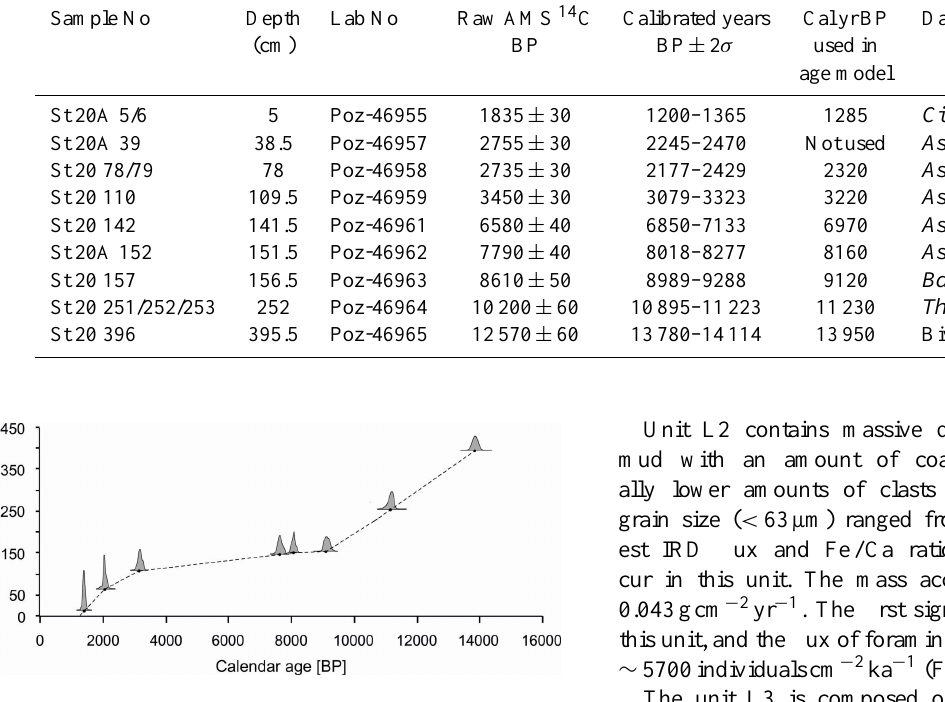
Figure 3. Age–depth relationship for JM09-020-GC based on eight AMS 14 C calibrated ages with 2-sigma age probability distribution curves. The chronology is established by linear interpolation be- tween the calibrated